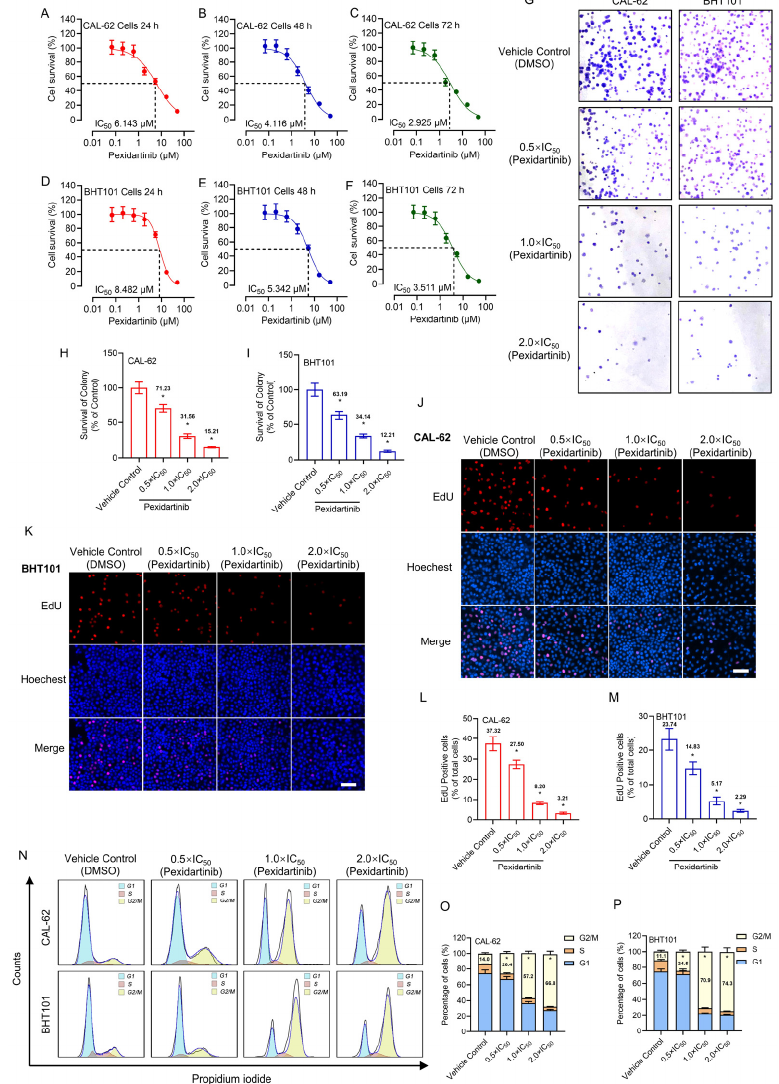
Figure 1. Pexidartinib inhibits ATC cells proliferation: ( A – C ) Viability ‐ survival curves of CAL ‐ 62 cells treated with different concentrations of pexidartinib for 24 h, 48 h, and 72 h, respectively. ( D – F ) Viability ‐ survival curves of BHT101 cells treated with pexidartinib for 24 h, 48 h, and 72 h, respectively. ( G ) Colony formation assays of CAL ‐ 62 and BHT101 cells treated with pexidartinib at 0.5 × IC 50 , 1 × IC 50 , and 2×IC 50 concentrations. ( H , I ) Relative survival of colony detected in CAL ‐ 62 and BHT101 cells treated with pexidartinib at 0.5 × IC 50 , 1 × IC 50 , and 2 × IC 50 concentrations. ( J – M ) EdU detection in CAL ‐ 62 and BHT101 cells treated with pexidartinib at 0.5 × IC 50 , 1 × IC 50 , and 2 × IC 50 concentrations. ( N ) Cell cycle distribution after pexidartinib (0.5 × IC 50 , 1 × IC 50 , and 2 × IC 50 concentrations) treatment in CAL ‐ 62 and BHT101 cells. ( O , P ) Statistical analysis of cell cycle distribution after pexidartinib (0.5 × IC 50 , 1 × IC 50 , and 2 × IC 50 concentrations) treatment in CAL ‐ 62 and BHT101 cells. Data are presented as mean ± SD in at least three independent experiments (significance is presented as * when p < 0.05).